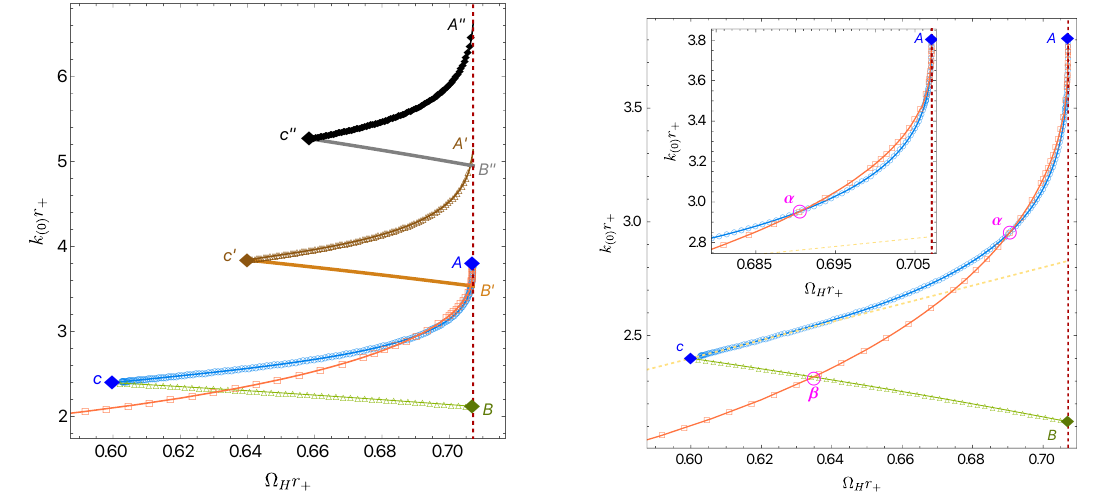
Figure 6 . Left panel: regions ABc , A 0 B 0 c 0 , and A 00 B 00 c 00 where Myers-Perry black strings are unstable to m = 2 , 3 , 4 superradiant modes, respectively. The orange squares correspond to the onset of the Gregory-Laflamme instability already shown in figures 1 and 3 (the region below this curve is unstable). Right panel: zoom-in of region unstable to both Gregory-Laflamme and superradiance. α and β mark where the Gregory-Laflamme onset curve intersects with the m = 2 unstable superradiant region. α lies at ( e Ω H , e k , e L ) α ' (0 . 69054 , 2 . 95350 , 2 . 12737) , where to (0) (0) (cid:12) (cid:12) (cid:12) (cid:12) the left of α one has e k > e k , while to the right of α one has e k < e k . β lies at (cid:12) (cid:12) (cid:12) (cid:12) (0) (0) (0) (0) SR GL SR GL ( e Ω H , e k , e L ) β ' (0 . 63478 , 2 . 31810 , 2 . 71049) . (0) (0) approach the points A , A 0 and A 00 at extremality as given by (4.15). Perturbations with adjacent m ’s also overlap in some small regions of parameter space close to